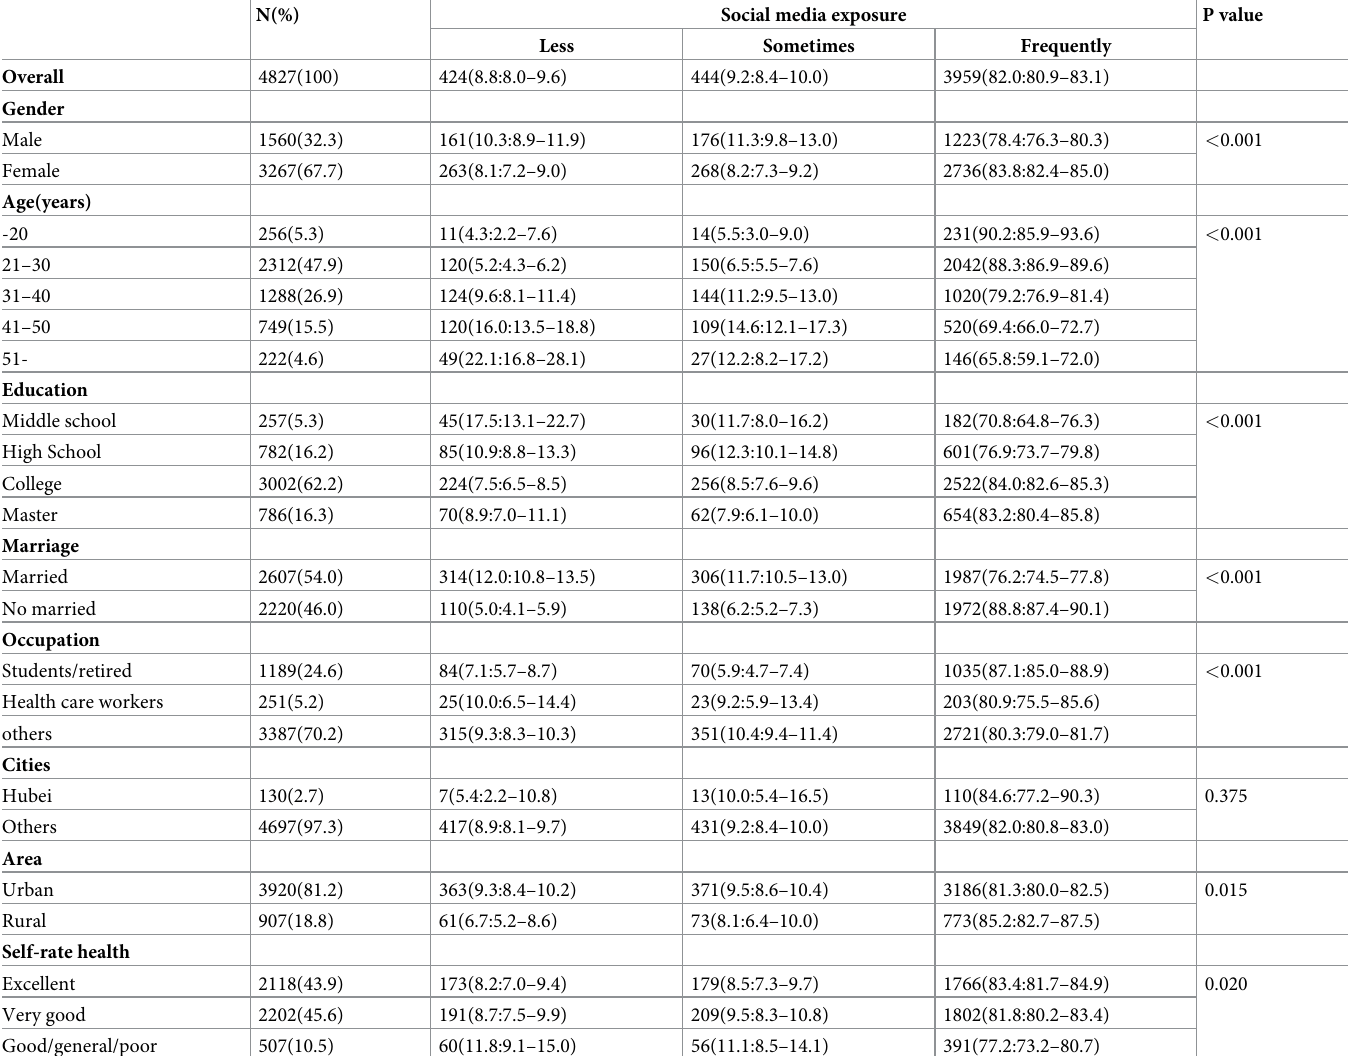
Table 1. Participants characteristic and social media